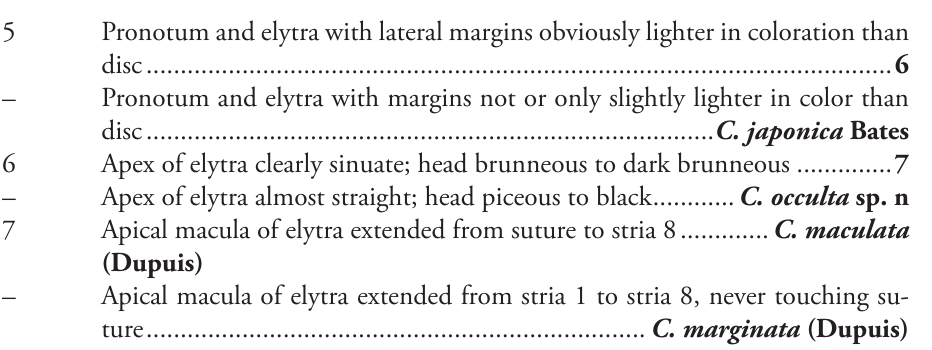
Coptodera nobilis Jedlička, 1963: 349; Lorenz 2005: 458. syn. n. Types and other material examined. 28 specimens of C. chaudoiri : 17 males and eleven females. Types of both C. transversa anguilipennis and C. nobilis were examined and dissected. Specimens of these proposed species did not differ in any way from C. chaudoiri , other than the very slight and normal variability typical of the subgenus Cop- toderina . For further details see EH Strickland Virtual Entomology Museum Database.